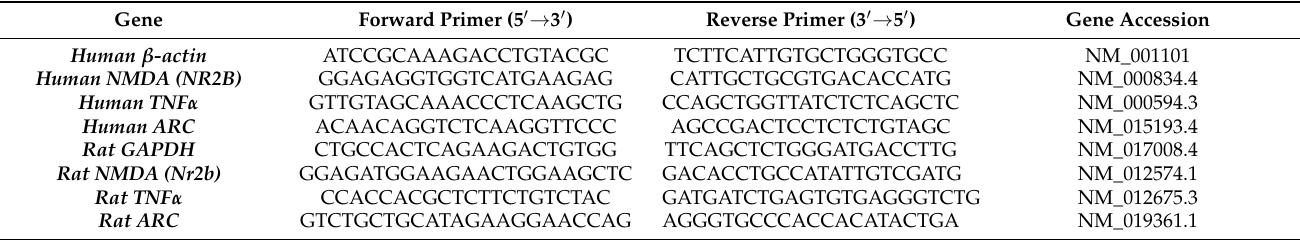
Table 1. Primers used for the quantitative polymerase chain reaction. Gene Forward Primer (5 (cid:48) → 3 (cid:48)